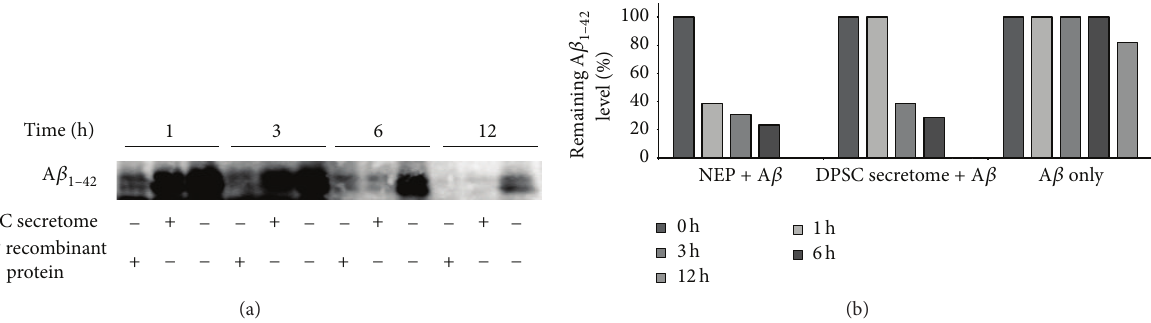
Figure 6: DPSC secretome degrades A 𝛽 1 protein in vitro. (a) Immunoblotting analysis at each time point with an anti-A 𝛽 antibody (full- – 42 length blots are presented in Supplementary Figure S4). (b) Quantitation of remaining A 𝛽 1